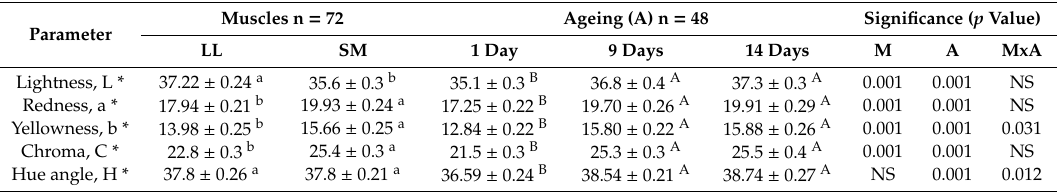
Table 2. The influence of muscles (M) and ageing time (A) on color parameters (20 min blooming) of LL and (25 min blooming) of SM (mean values ± SEM).